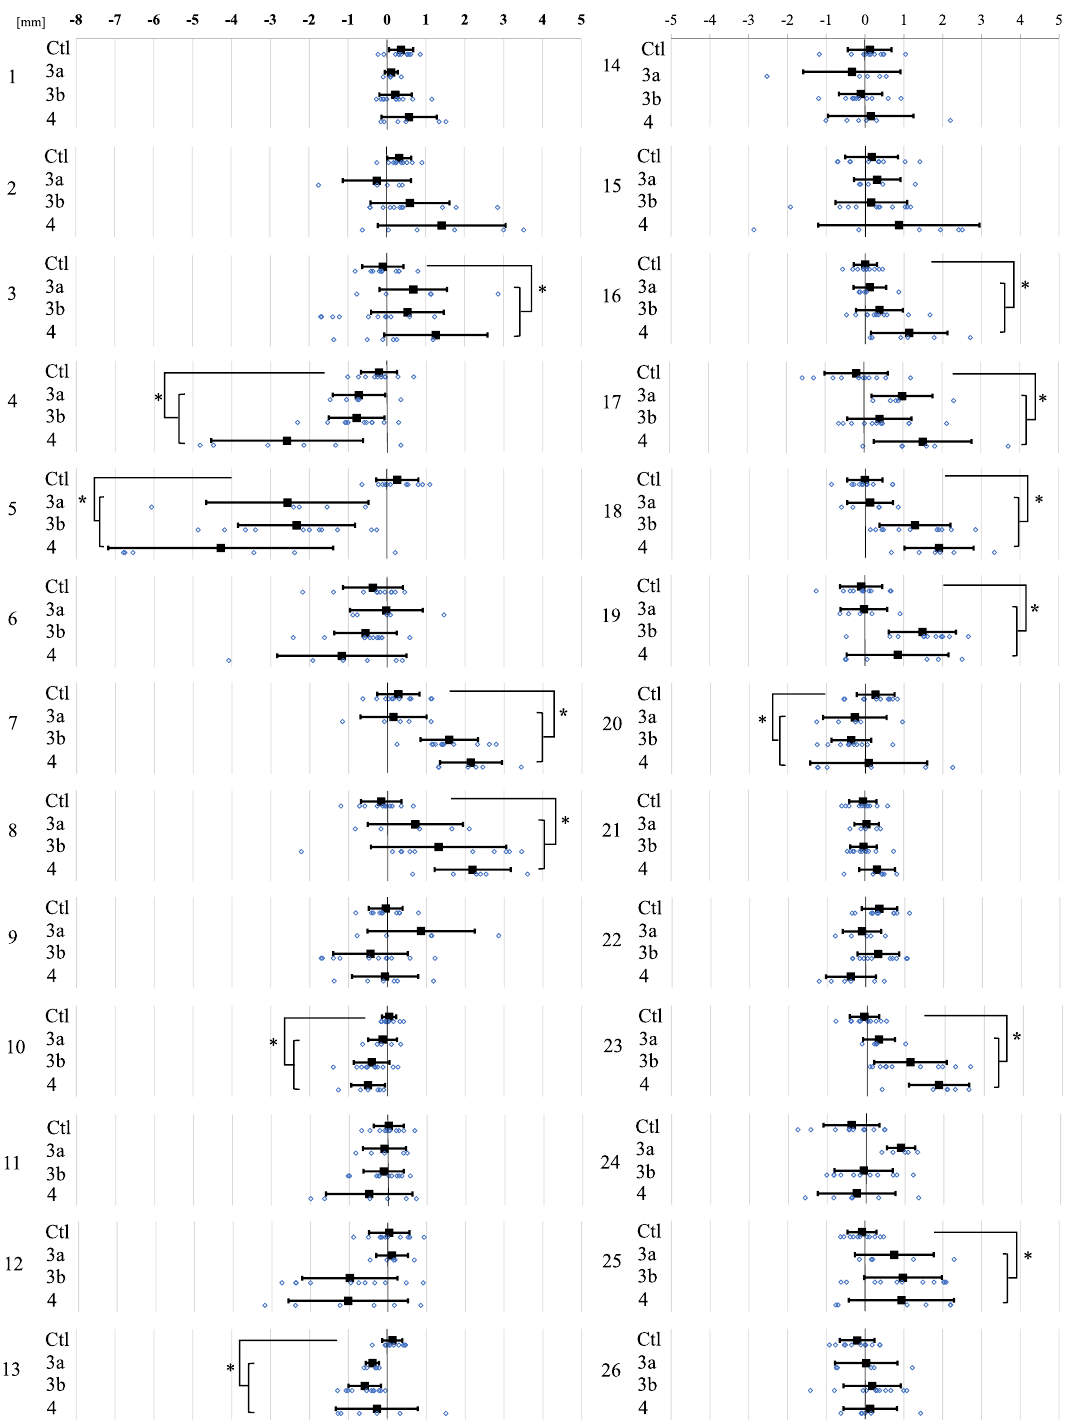
Figure 4. The amounts of left–right surface deviations in the OA and control groups at 26 regions of interest (See Table 1 and Fig. 5). Error bars indicate standard deviations. The deviations are positive if the surface of the OA or right surface is outside the opposite non-OA or left surface, and negative if the surface is inside. Three OA groups (3a, 3b, and 4) were pooled for statistical comparisons with the corresponding control. *Significant difference between the pooled OA and the control, p <